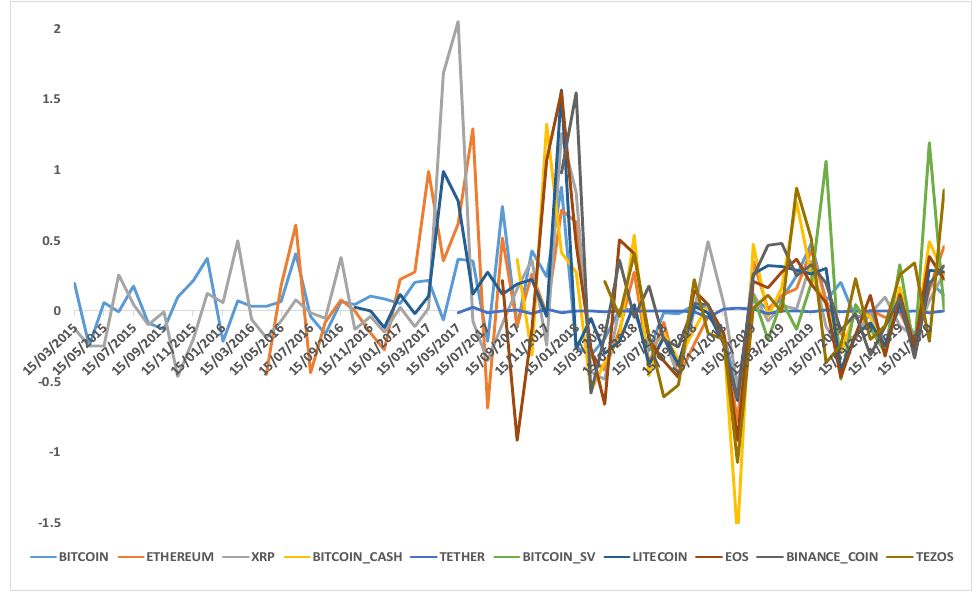
Figure 2. Time evolution of the Bitcoin returns and the rest of relevant cryptocurrency returns. Compiled by the authors, based on the information provided by the Coinmarketcap website.